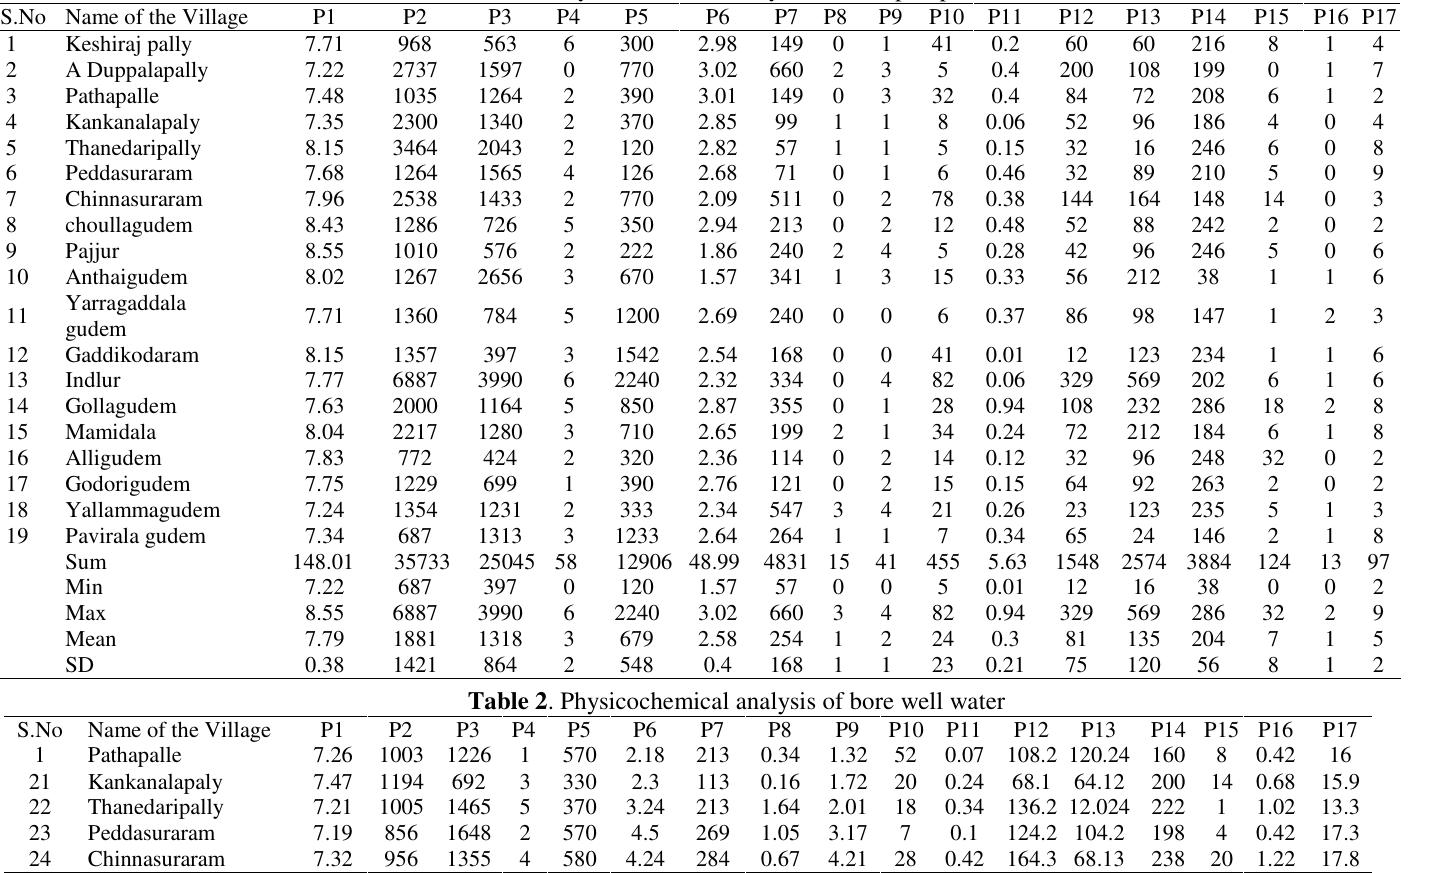
Table 1. Physicochemical analysis of hand pump water